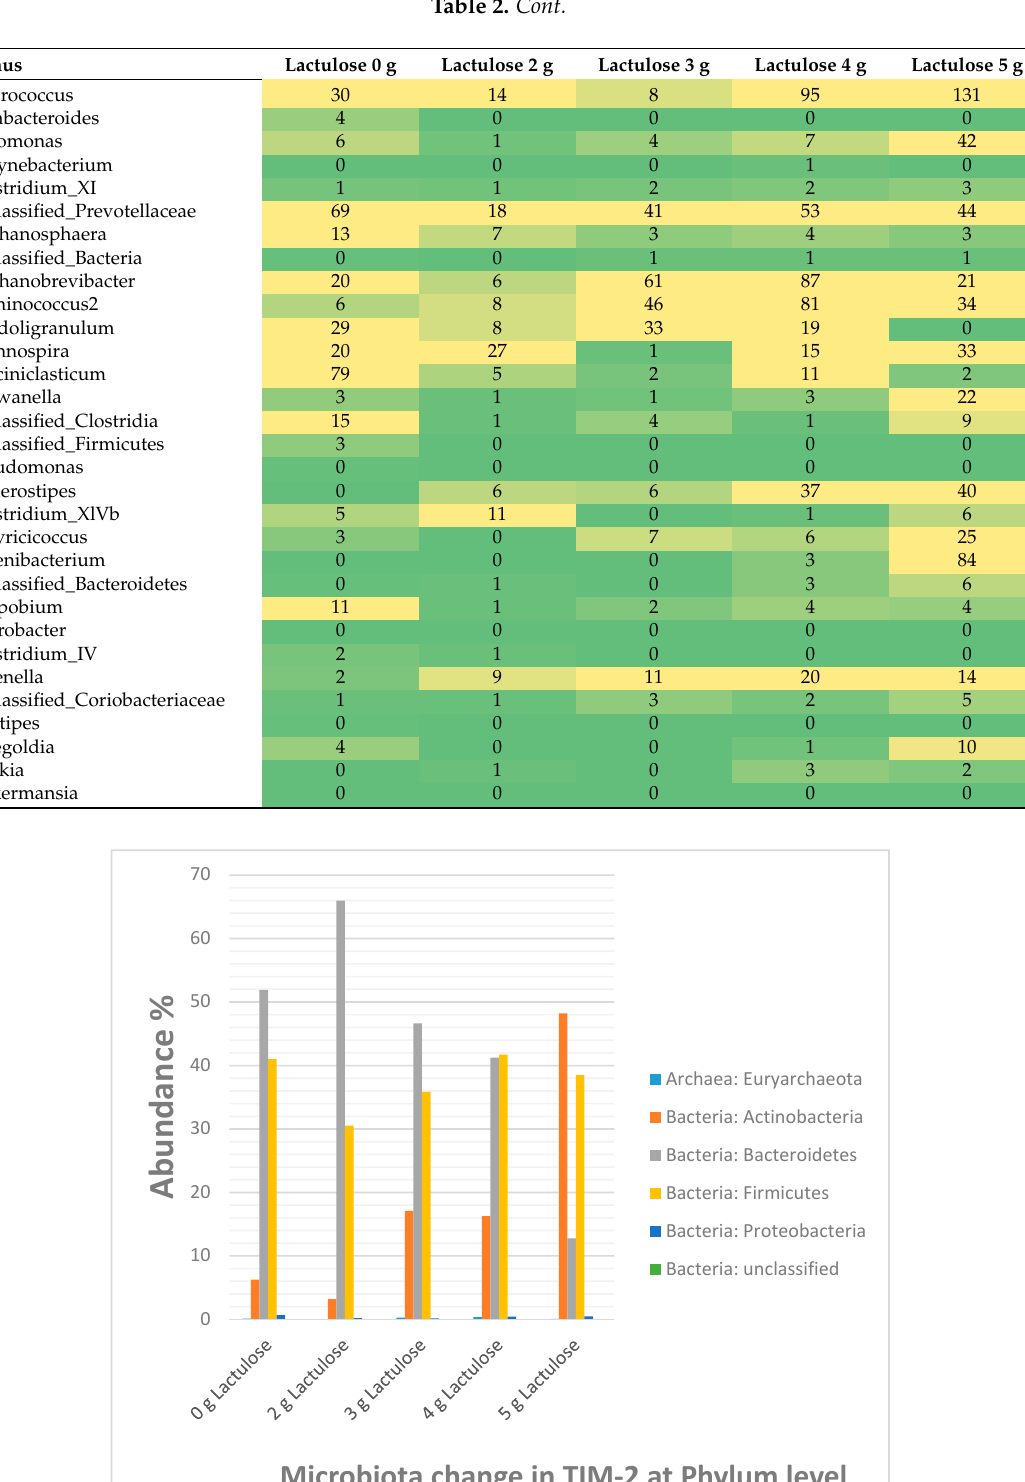
Figure 7. Column diagram of the bacterial distribution in percentage at the phylum level in control (0 g Lactulose) and different Lactulose dosages, 2 g, 3 g, 4 g and 5 g respectively. Apart from the 2 g lactulose data, an increase is observed with respect to the phylum Actinobacteria while a decrease is observed with respect to the phylum Bacteroidetes . The relative abundance of the Firmicutes is affected to a lesser